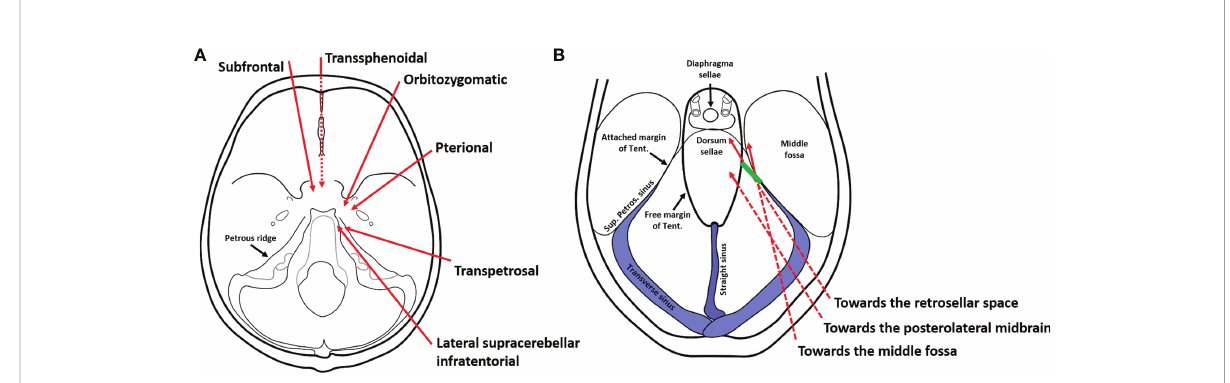
FIGURE 5 Schematic diagrams of surgical approaches for the resection of retroinfundibular craniopharyngiomas. (A) Current approaches for the resection of retroinfundibular craniopharyngiomas include anterior midline approaches (the transsphenoidal approach and the subrontal approach), anterolateral approaches (the peterional approach and orbitozygomatic approach), and posterolateral appoaches (the transpetrosal approach and the lateral supracerebellar/infratentorial approach described herein). The dotted line indicates the surgical corridor underneath the skull base. (B) The lateral supracerebellar/infratentorial approach was originaly used for resection of lesions in the posterolateral midbrain and tentorial region. However, the incision of the tentorium broadens the range of exposure towards the retrosellar space for resection of retroinfundibular craniopharyngiomas as well as the middle fossa for resection of petroclival region meningioma with supratentorial extenstion. The dotted line indicates the surgical corridor underneath the tentorium. The green line denotes the incision site of the